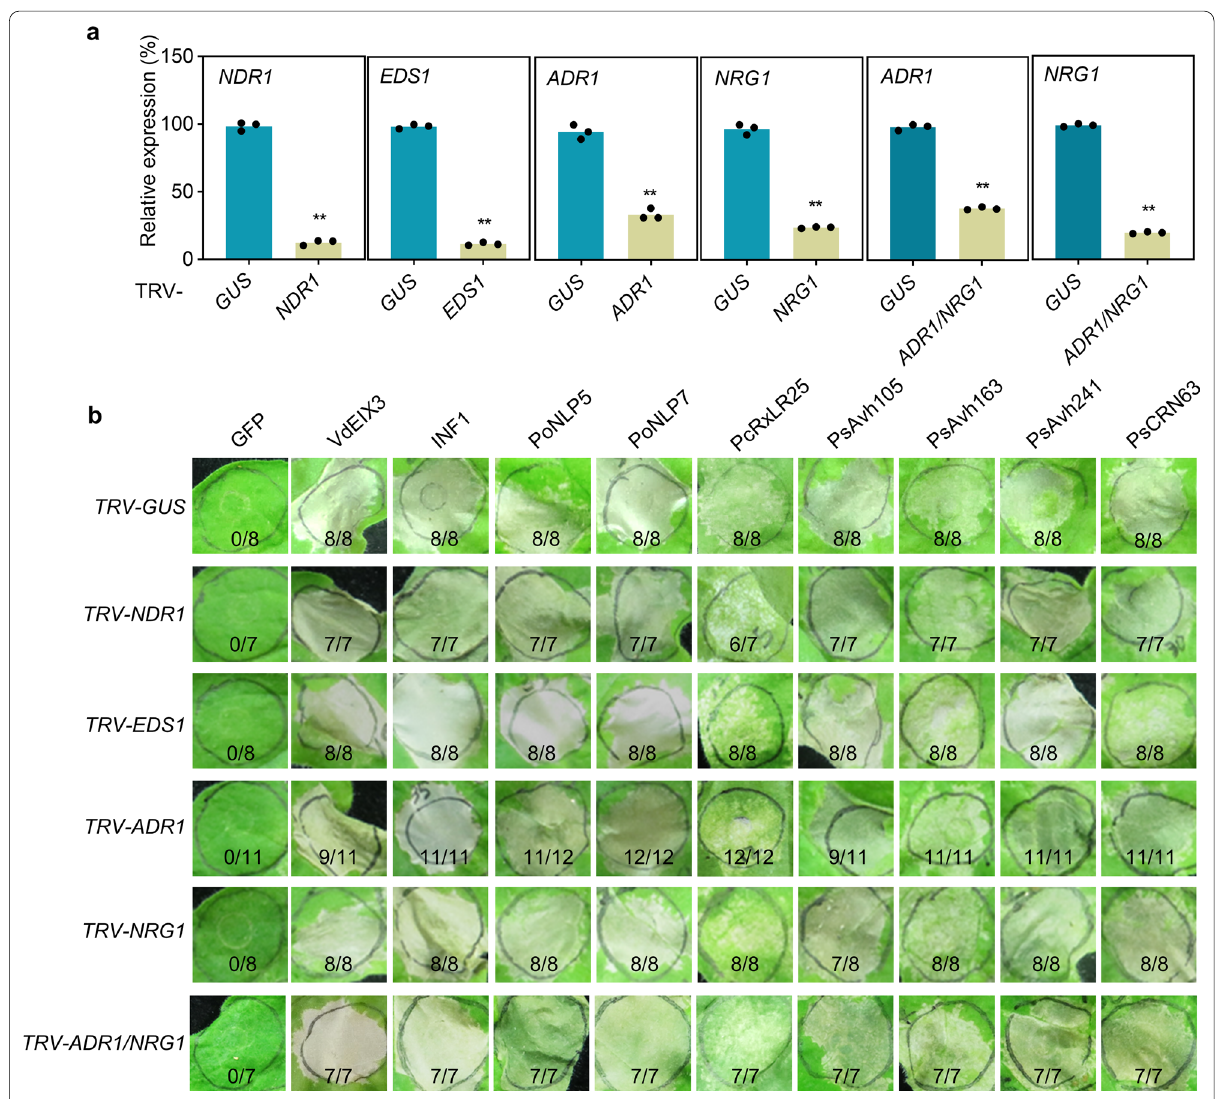
Fig. 3 Cell death induced by the eight effectors does not require ADR1 , NRG1 , NDR1 and EDS1 . a Evaluation of the silencing efficiency of the indicated gene in ADR1- , NRG1- , NDR1-, EDS1- and ADR1 / NRG1- silenced N. benthamiana plants using RT-qPCR. The EF1a gene was used as an internal reference. Bars represent standard errors from three independent biological replicates (mean GUS-silenced lines; Student’s t -test). b Phenotypes of eight effectors in gene-silenced leaves. Photos were taken at 6 dpi. Consistent results were observed from three independent biological experiments, with each having at least seven repetitions. Numbers represent the number of leaves showing cell death out of the number of leaves